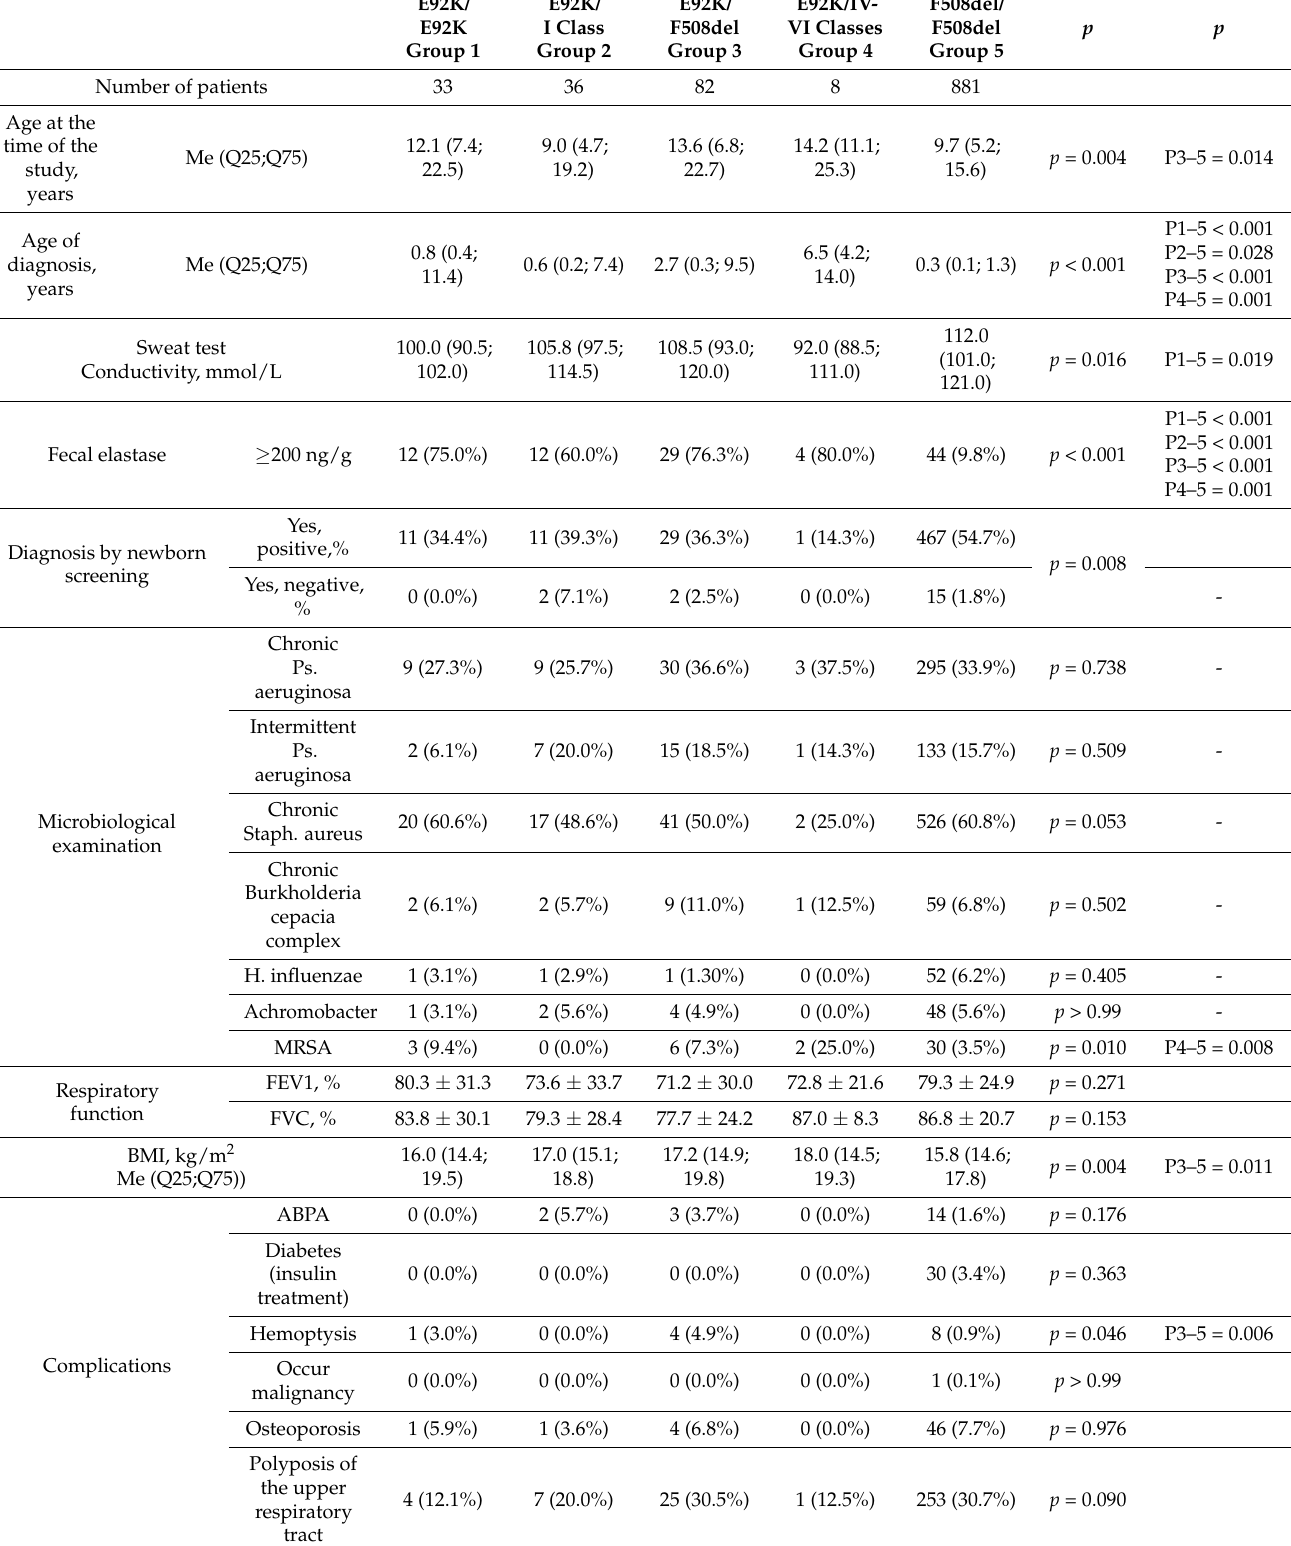
Table 1. Clinical characteristics of cystic fibrosis patients with different